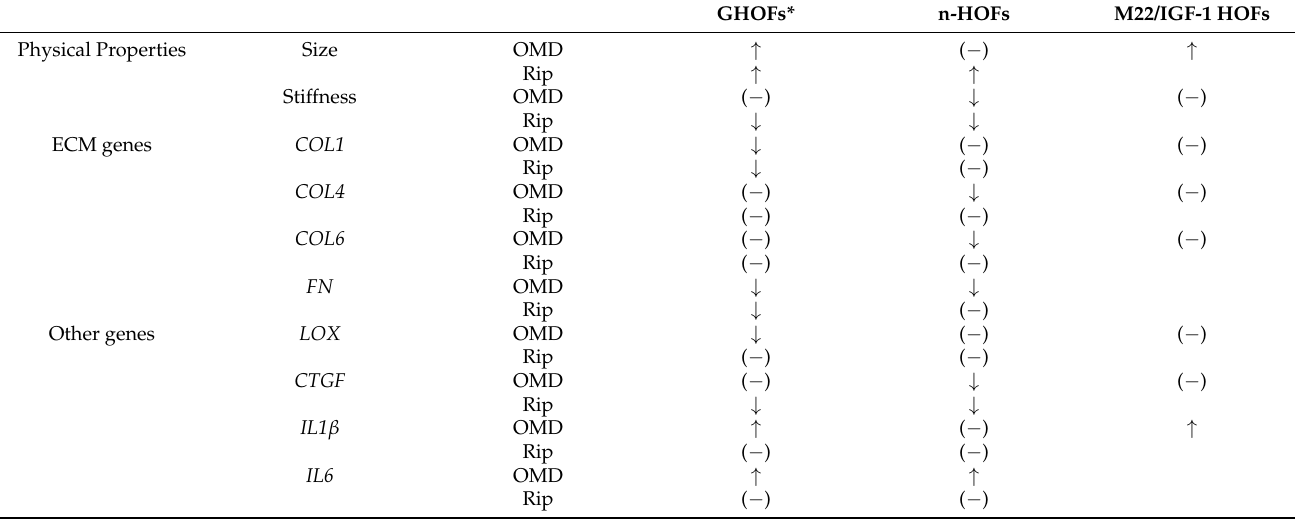
Table 2. Comparison of physical properties, size and stiffness, and mRNA expressions of ECM and other genes between 3D GHOFs spheroid, 3D n-HOFs spheroid and M22/IGF-1-treated 3D n-HOFs spheroid in the presence of OMD or Rip. Physical Properties